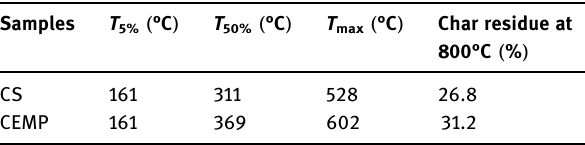
Table 2: TG data of CS and CEMP Samples